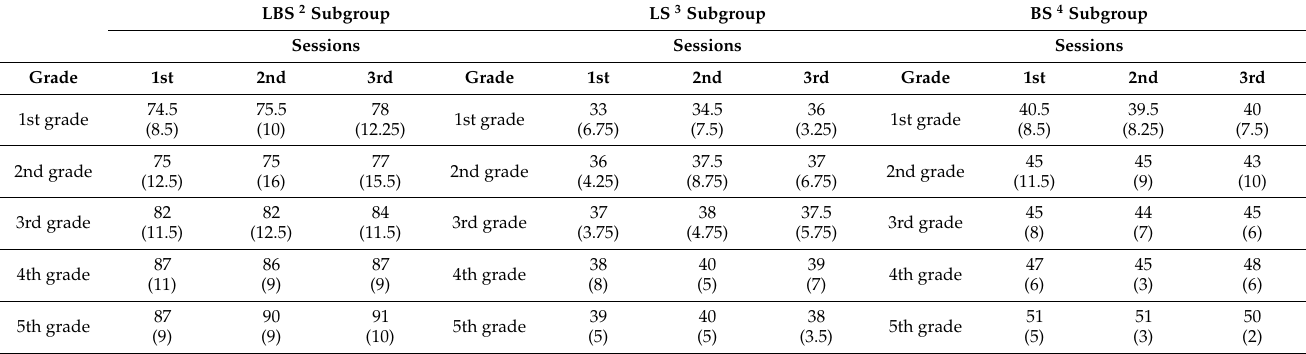
Table 9. TGMD-3 scores 1 for all grades and all subgroups of gross motor skills training. LBS 2 Subgroup LS 3 Subgroup